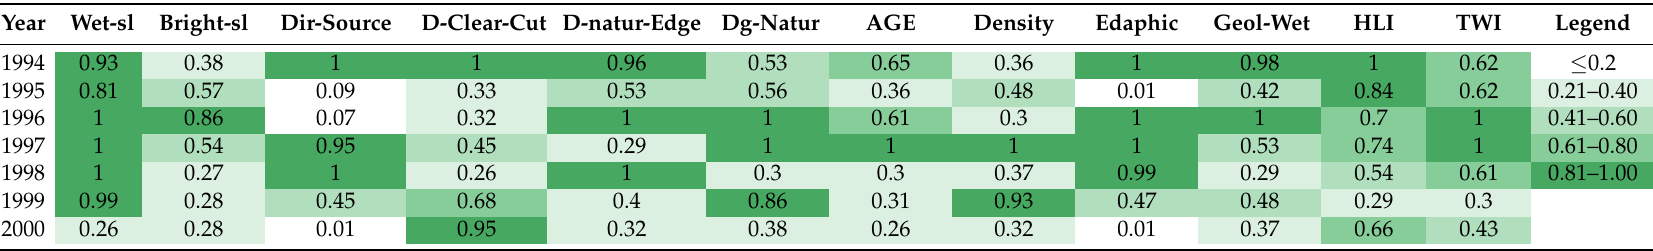
Table 3. Predictor importance weights based on multimodel inference when both pre-disturbance indices are used as predictors. The darkest/lightest green show the highest/lowers predictor importance